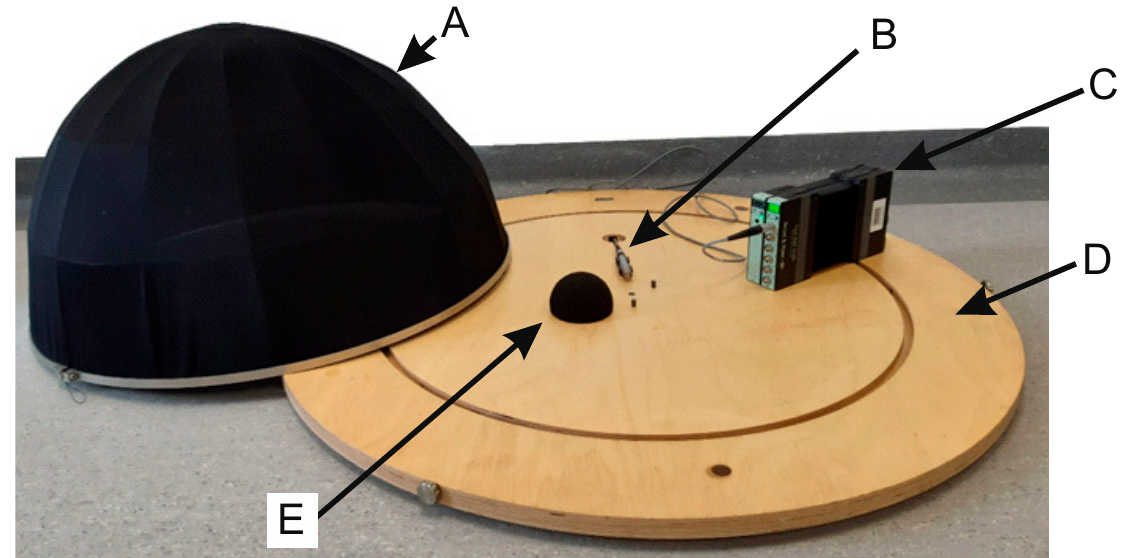
Figure 2. General view of the measurement setup: A—outer wind protection, B—condenser micro- phone type 4190, C—PULSE LAN-XI type 3050-A module, D—reflective board, E—inner wind pro-